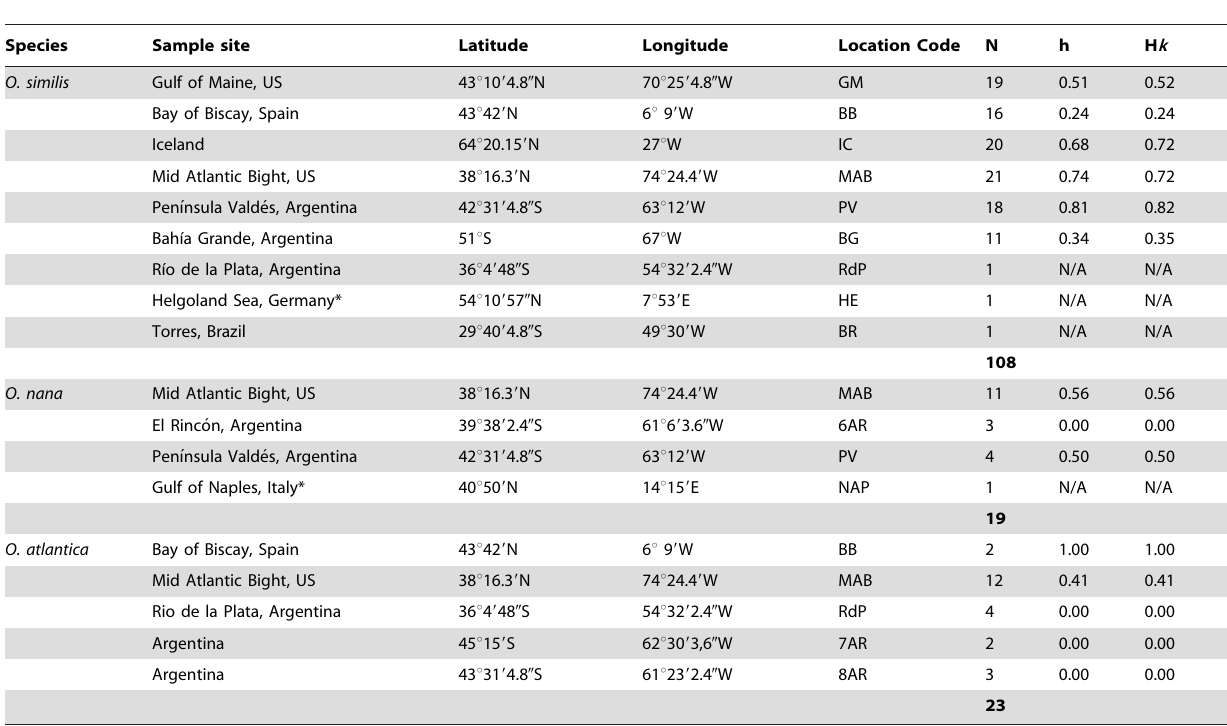
Table 1. Sample sites, latitude, longitude, location code, sample size (N), sequence diversity ( h ), standarized sequence diversity (Hk) and number of kind sequences in each population of O. similis , O. nana and O. atlantica collected for this study from the Atlantic Ocean.